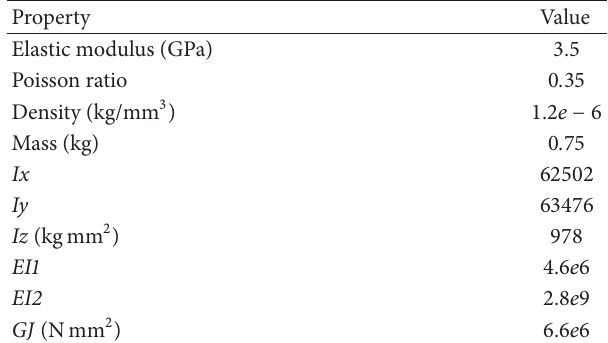
Table 1: Material properties of (5 × 125 × 1000mm) PC used in FE